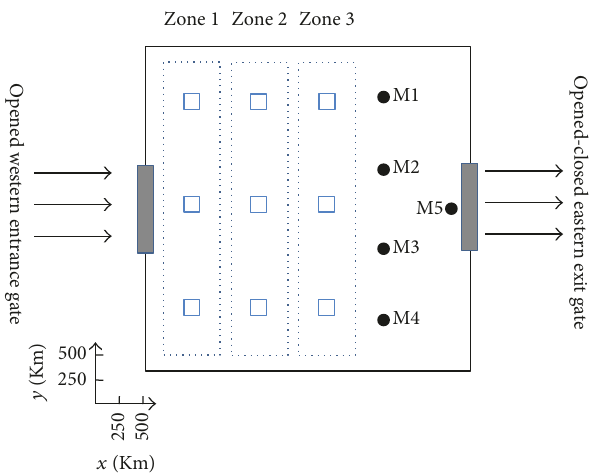
Figure 1: An opened-closed reservoir with contaminant removal mechanism zones and monitoring points M1, M2, M3, M4, and